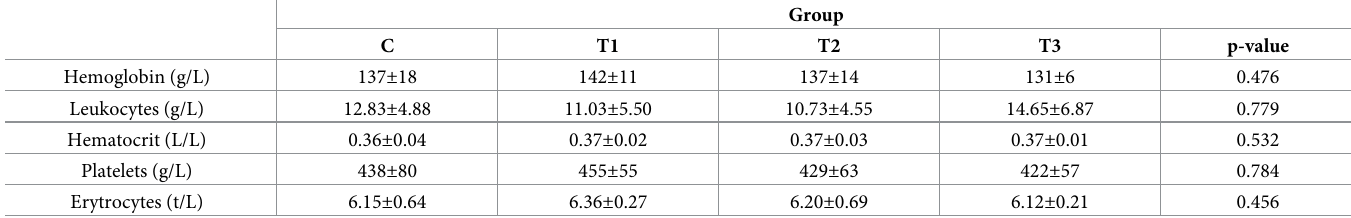
Table 8. Haematological parameters.